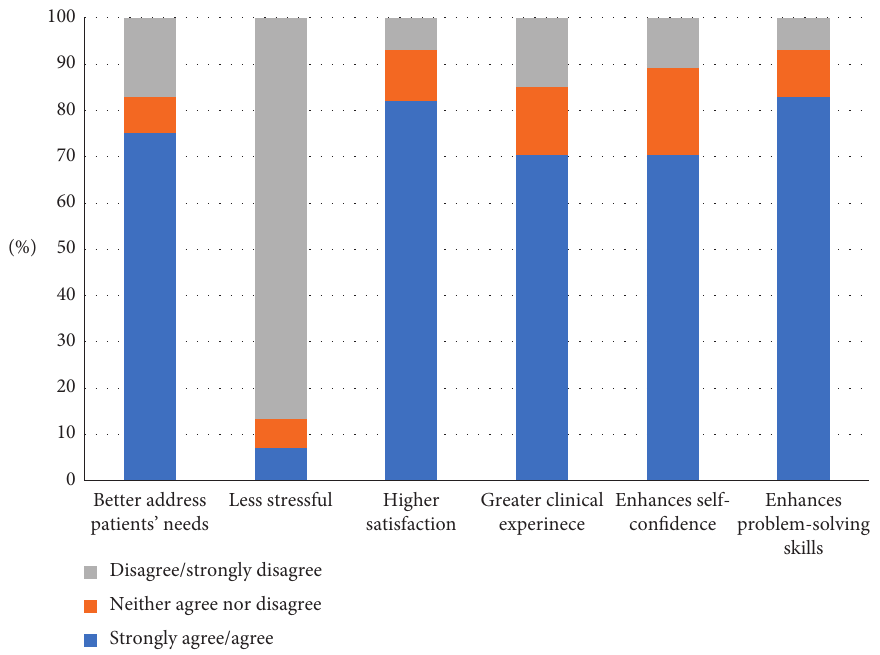
Figure 1: Percentages of students’ responses regarding benefits of the comprehensive patient